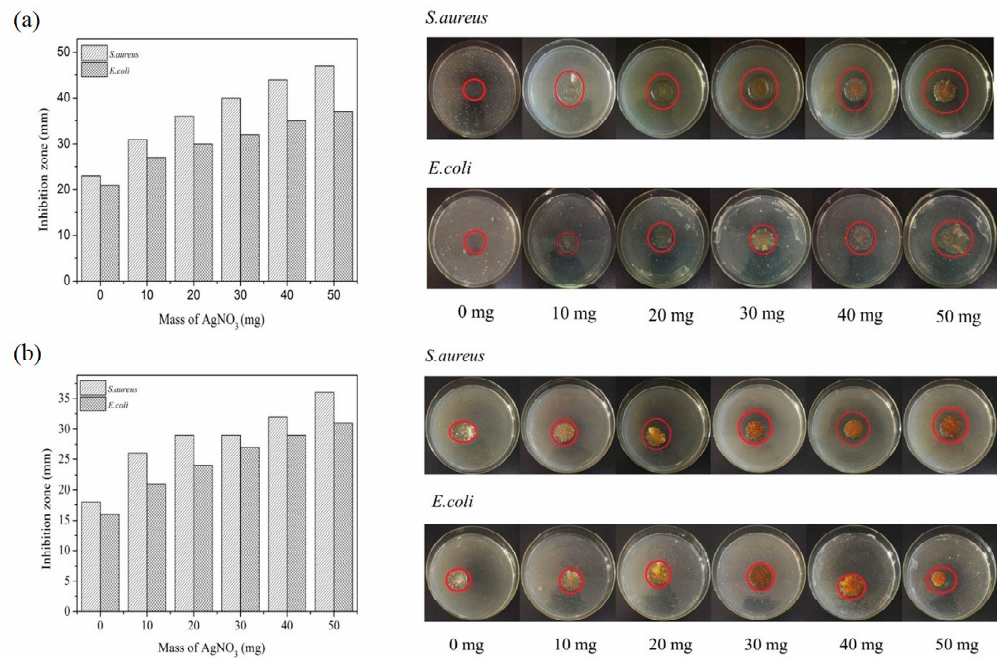
Figure 9. The antibacterial activity of the samples ( a ) and the dried samples after swelling in distilled water ( b ). water ( b